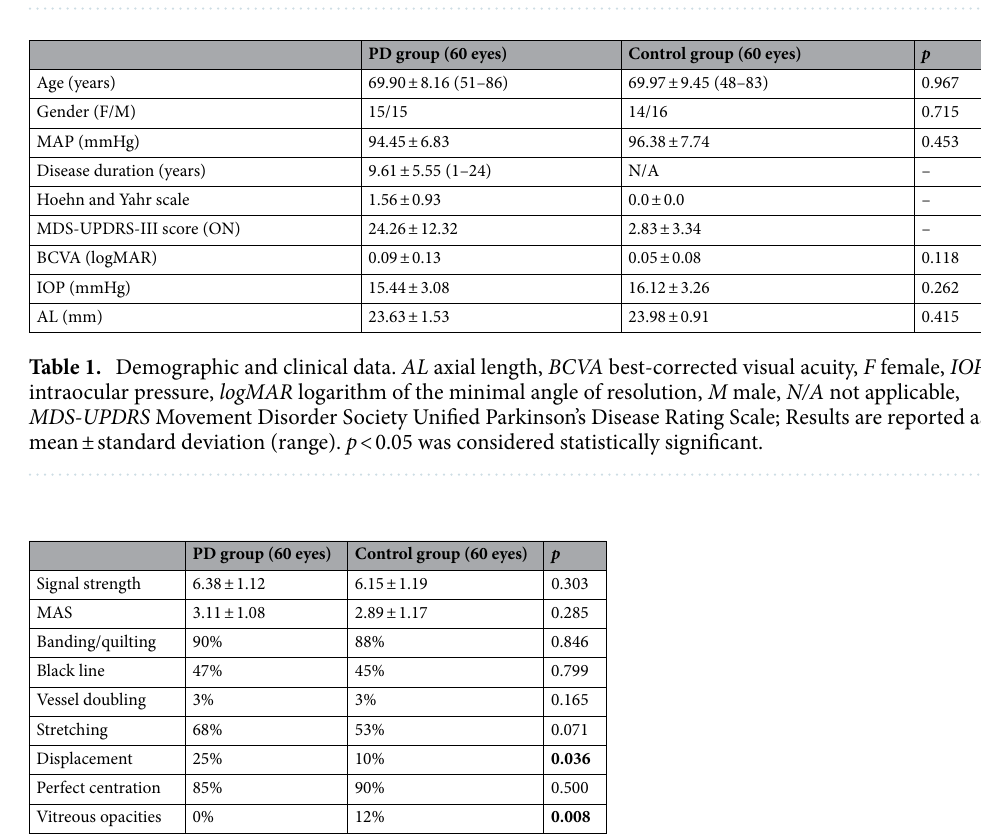
Figure 1. The motion artifact score (MAS) ranges from 1 to 4. While a MAS of 1 ( A ) indicates no or only slight banding/quilting and absence of all other artifacts due to motion or software correction, a MAS of 4 ( B ) implies significant banding/quilting in more than two quadrants, displacement in more than two quadrants, vessel doubling in more than two quadrants, stretch artifacts in more than two quadrants, or significant black line (Supplemental Table S1). While the former image ( A ) can be used for quantitative analysis of OCTA metrics, the latter one ( B ) should be excluded.